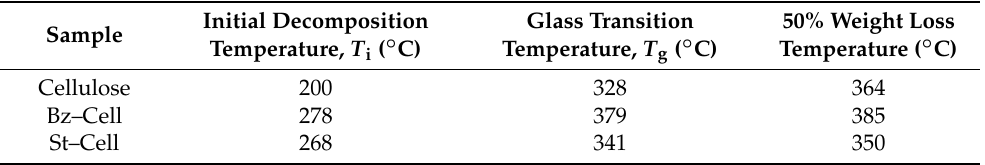
Table 2. TGA data of cellulose, Bz–Cell, and